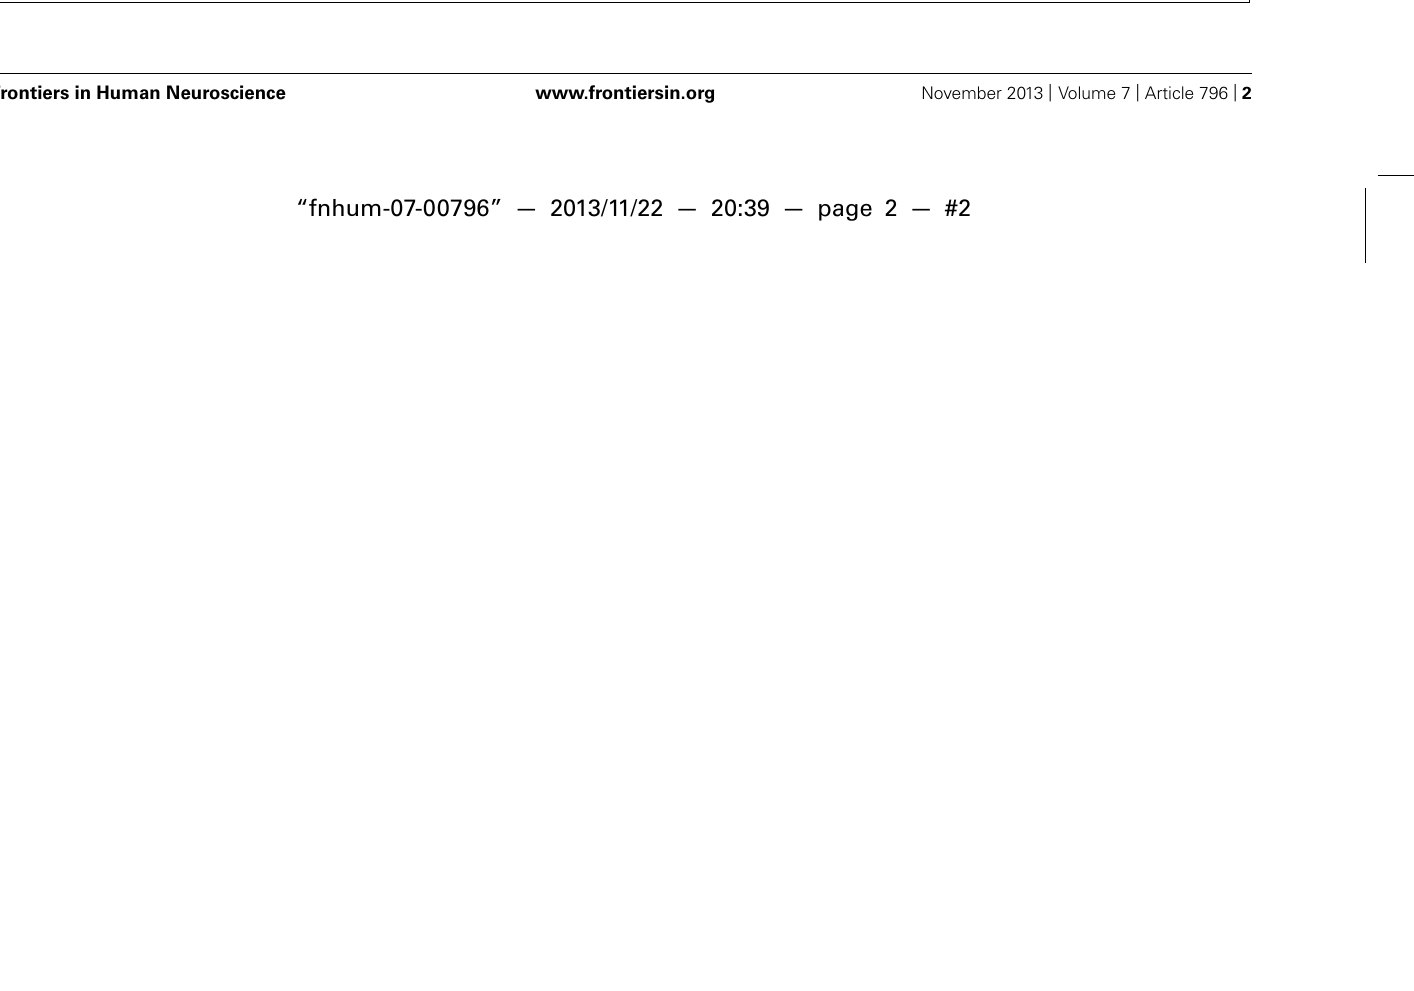
FIGURE 1 |Three-state model of memory. Left: illustration of the task used by Oberauer (2002) to test the three-state model of memory. Participants hold in mind two sets of digits. Red frames indicate the active set whose digits are candidates for processing (e.g., top set). Black frames indicate the passive set, which is recalled at the end of the trial, but not the subject of operations. Mathematical operations are applied to the active set thereby updating its contents. In this example, “ − 4” is applied to “5,” resulting in “1.” Subsequently, “ + 2” is applied to the result, yielding “3” and so on. At the end of the trial, all digits are recalled. In this example, going left to right starting from the top, recall would be “6,” “3,” “9,” “7,”